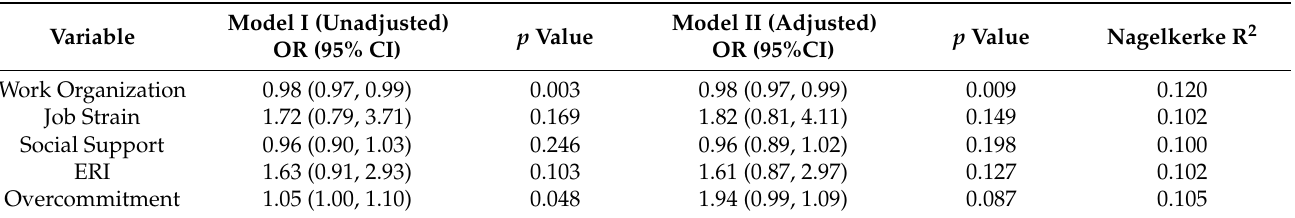
Figure 6. Johnson–Neyman Plot for of the relationship between work organization quality and psychological health, moderated by effort/reward imbalance. Table 6. Relationship between work organization, occupational stress, and the risk of having taken sickness absence for musculoskeletal disorders.